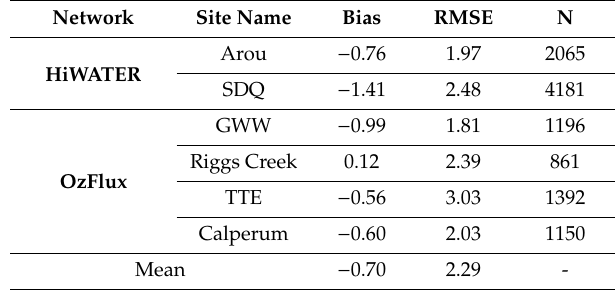
Table 8. Nighttime T-based validation results for the AHI LSTs at Heihe Watershed Allied Telemetry Experimental Research (HiWATER) and OzFlux over four